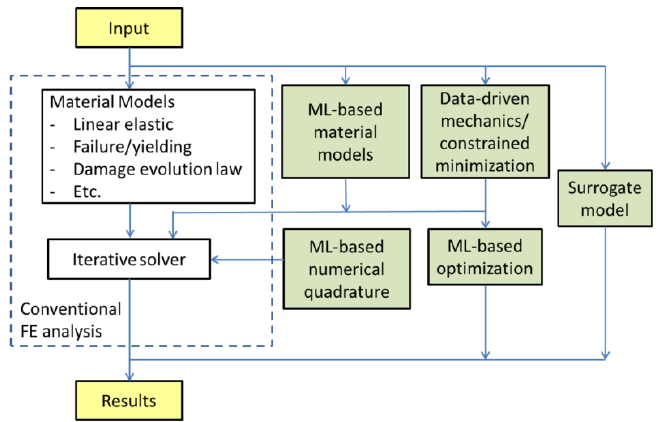
Figure 7. Summary of various machine learning (ML) methods for stress analysis from literature.